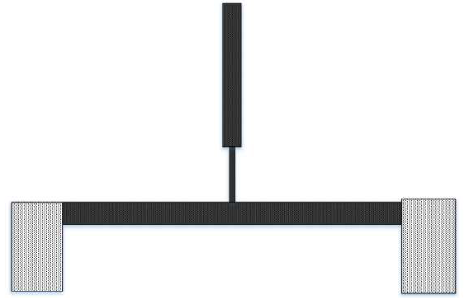
Figure 1. Schematic view of the modified micro T-beam.